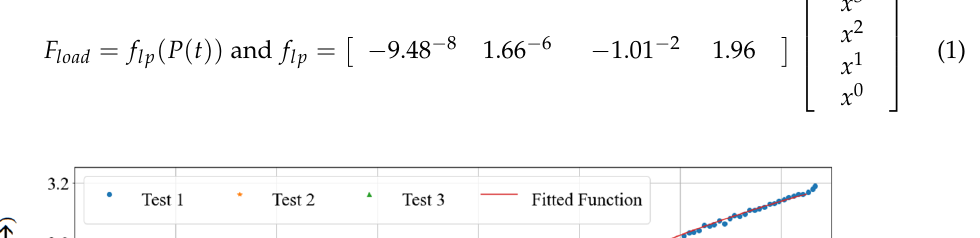
Based on Figure 7a, we modelled the relations between 𝑃(cid:4666)𝑡(cid:4667) and 𝐹 (cid:3039)(cid:3042)(cid:3028)(cid:3031) by polynomial